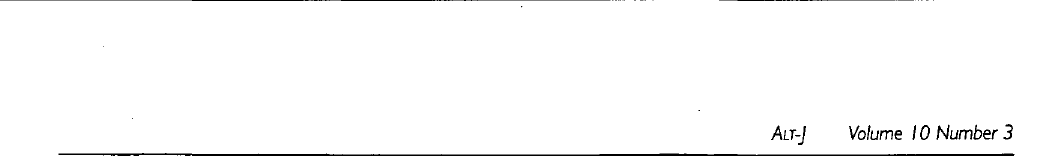
Figure 10: The subjective feedback on the number of links suggested in the reading room, with and without adaptive link hiding